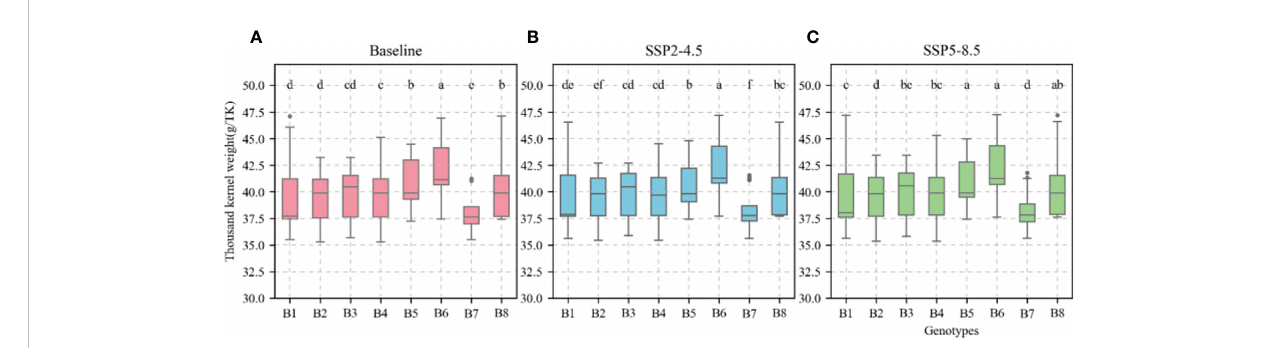
FIGURE 14 Thousand-kernel weight (TKW) of different allelic combination under different climatic scenarios at optimal sowing date. (A) , Baseline; (B) , SSP2-4.5; (C) , SSP2-8.5. Different letters indicate signi fi cance at 0.05